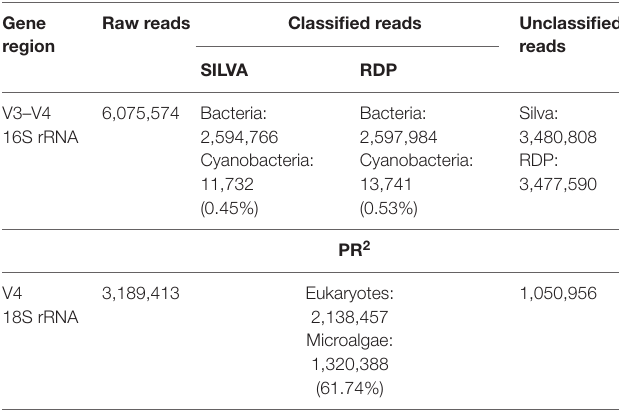
TABLE 2 | Number of reads obtained from sequencing data